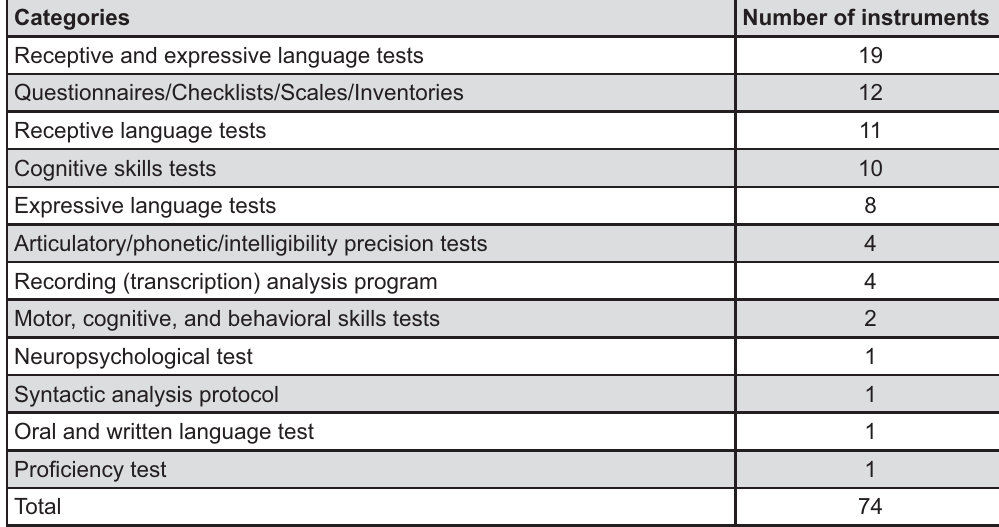
Figure 2- Number of instruments found by